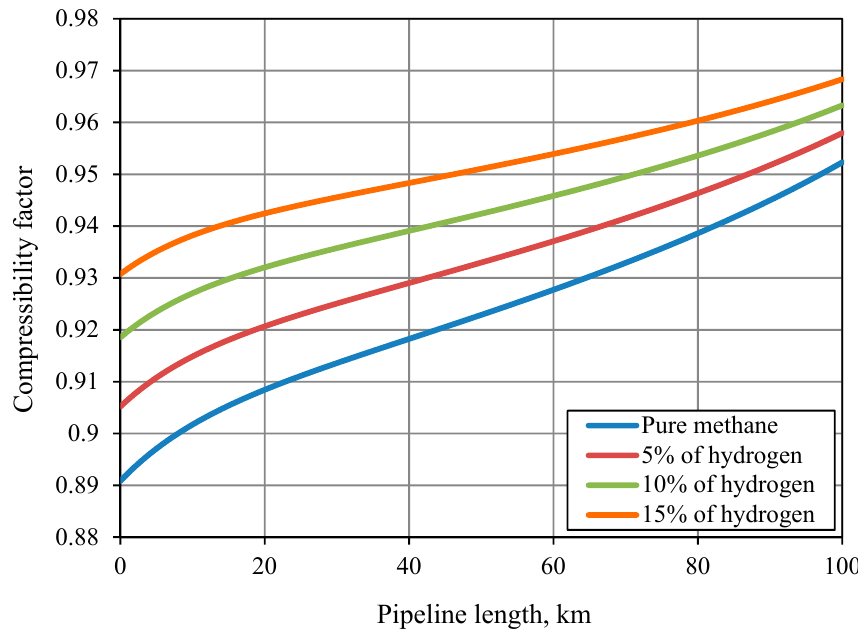
Figure 18. Compressibility factor changes as a function of hydrogen content and pipeline length.